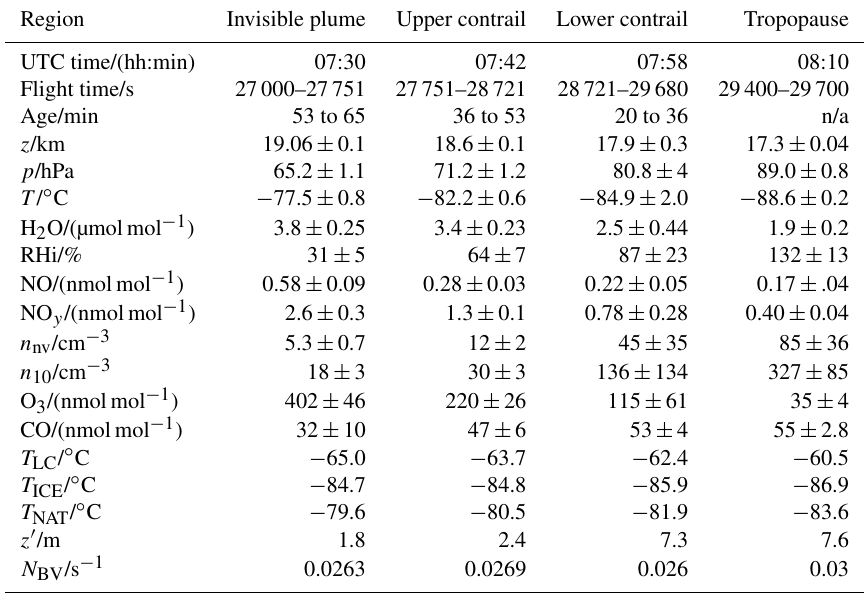
Table 2. Mean properties of uppermost invisible plume, upper (“white”) and lower (“red”) contrail, and tropopause properties with ranges or standard deviations for 16 November 2005 (n/a for not applicable).